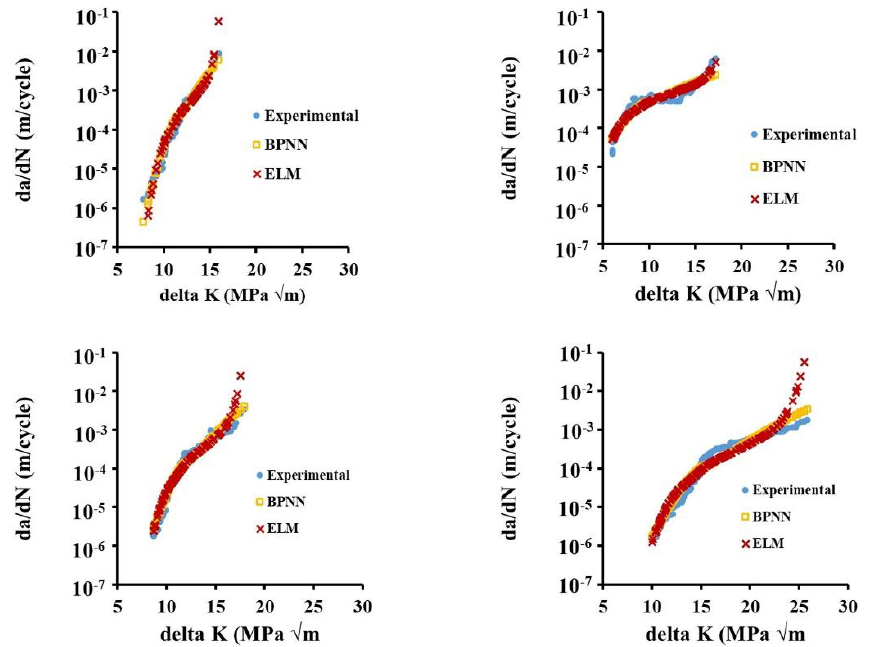
Figure 6. Extrapolation and comparison of experimental data with BPNN model and ELM model for: Table 1. Mean square error (MSE) of machine learning (ML) algorithms compared with polynomial curve fit method.